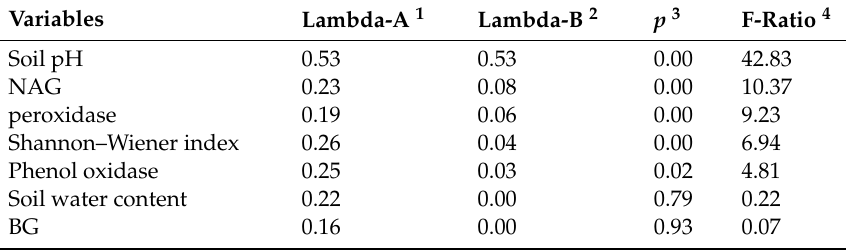
Table 6. Marginal and conditional e ff ects of soil pH, soil water content, and microbial community on soil carbon obtained from forward selection in redundancy analysis